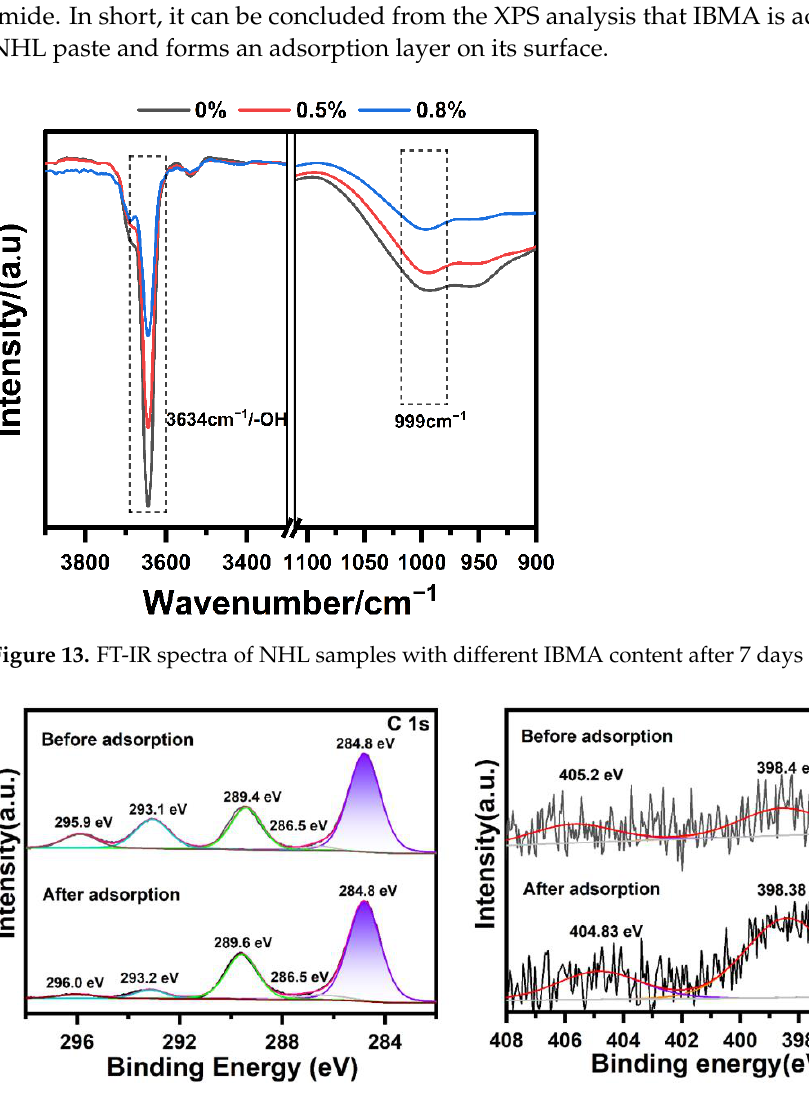
Figure 14. XPS patterns of NHL pastes with different IBMA content.